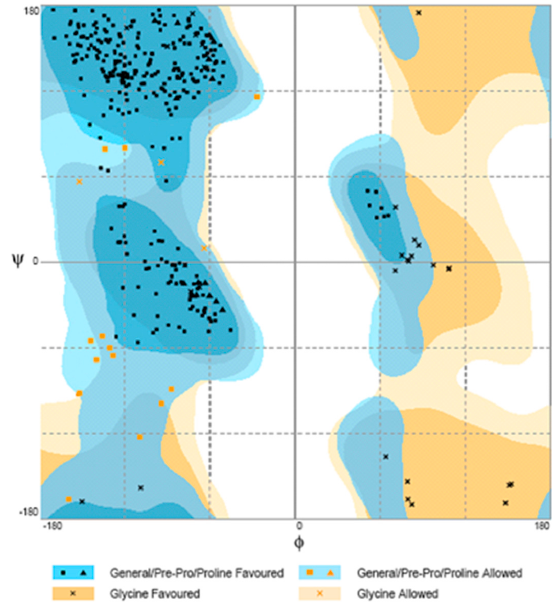
Figure 7. Ramachandran plot for modeled phytase obtained by PROCHECK.